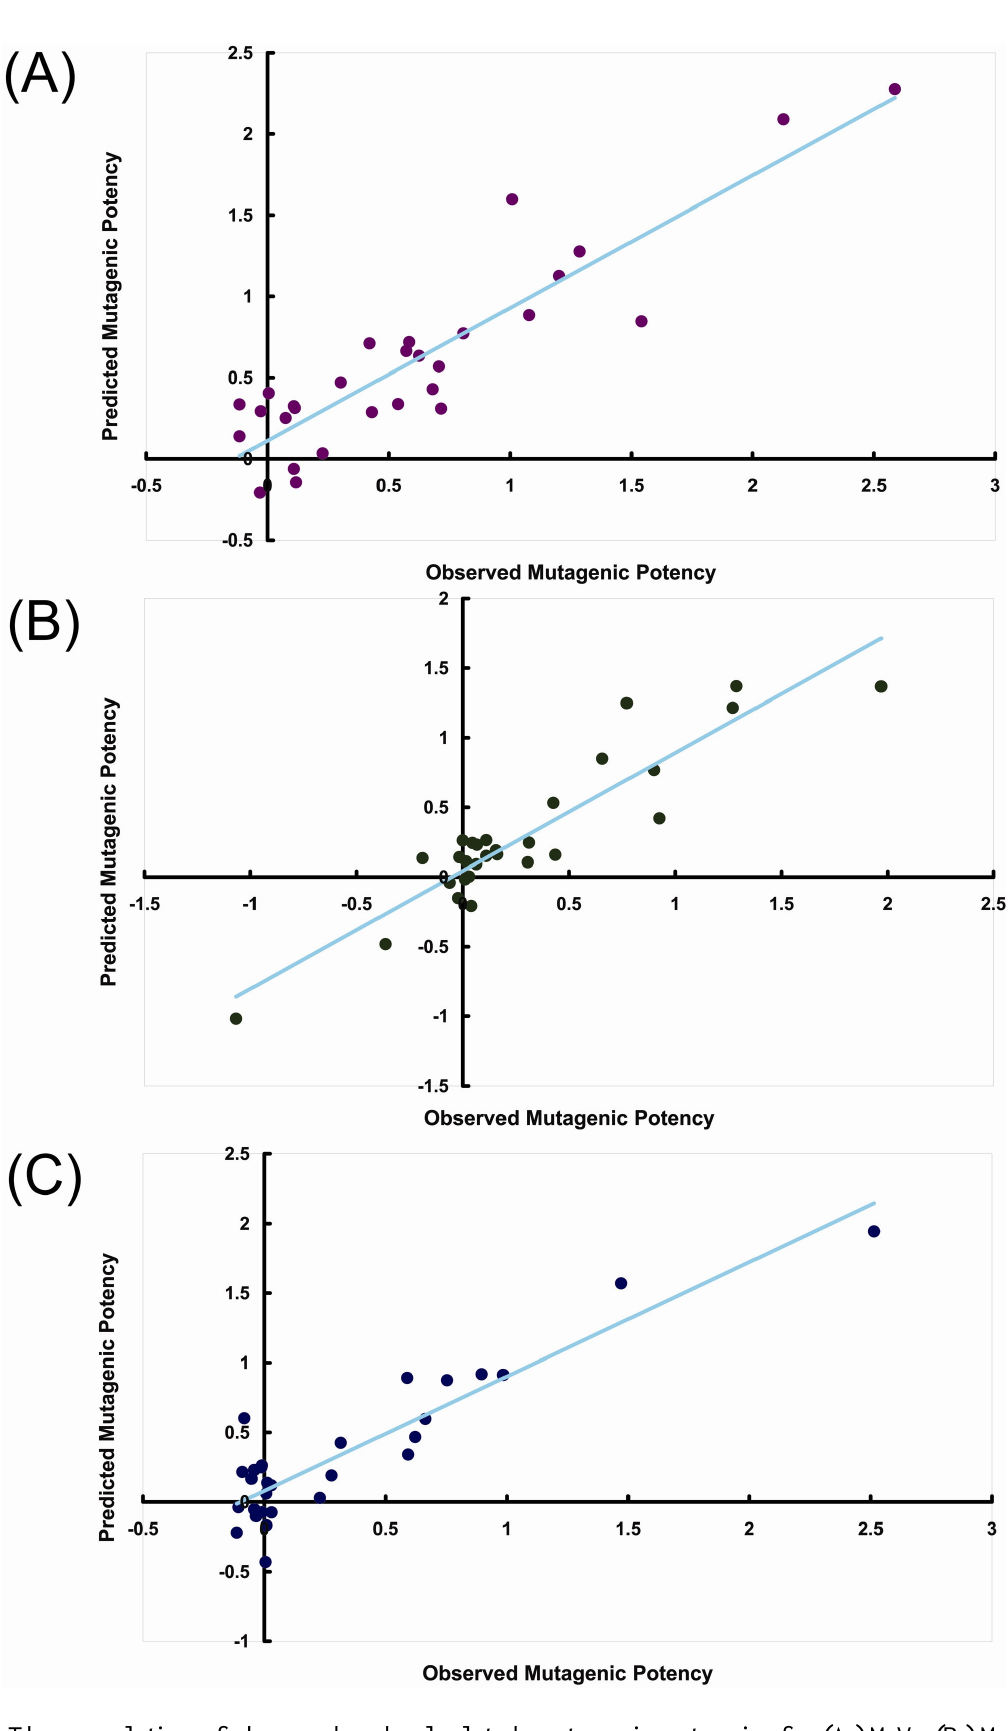
Figure 3. The correlation of observed and calculated mutagenic potencies for (A) MV, (B) MG, and (C)